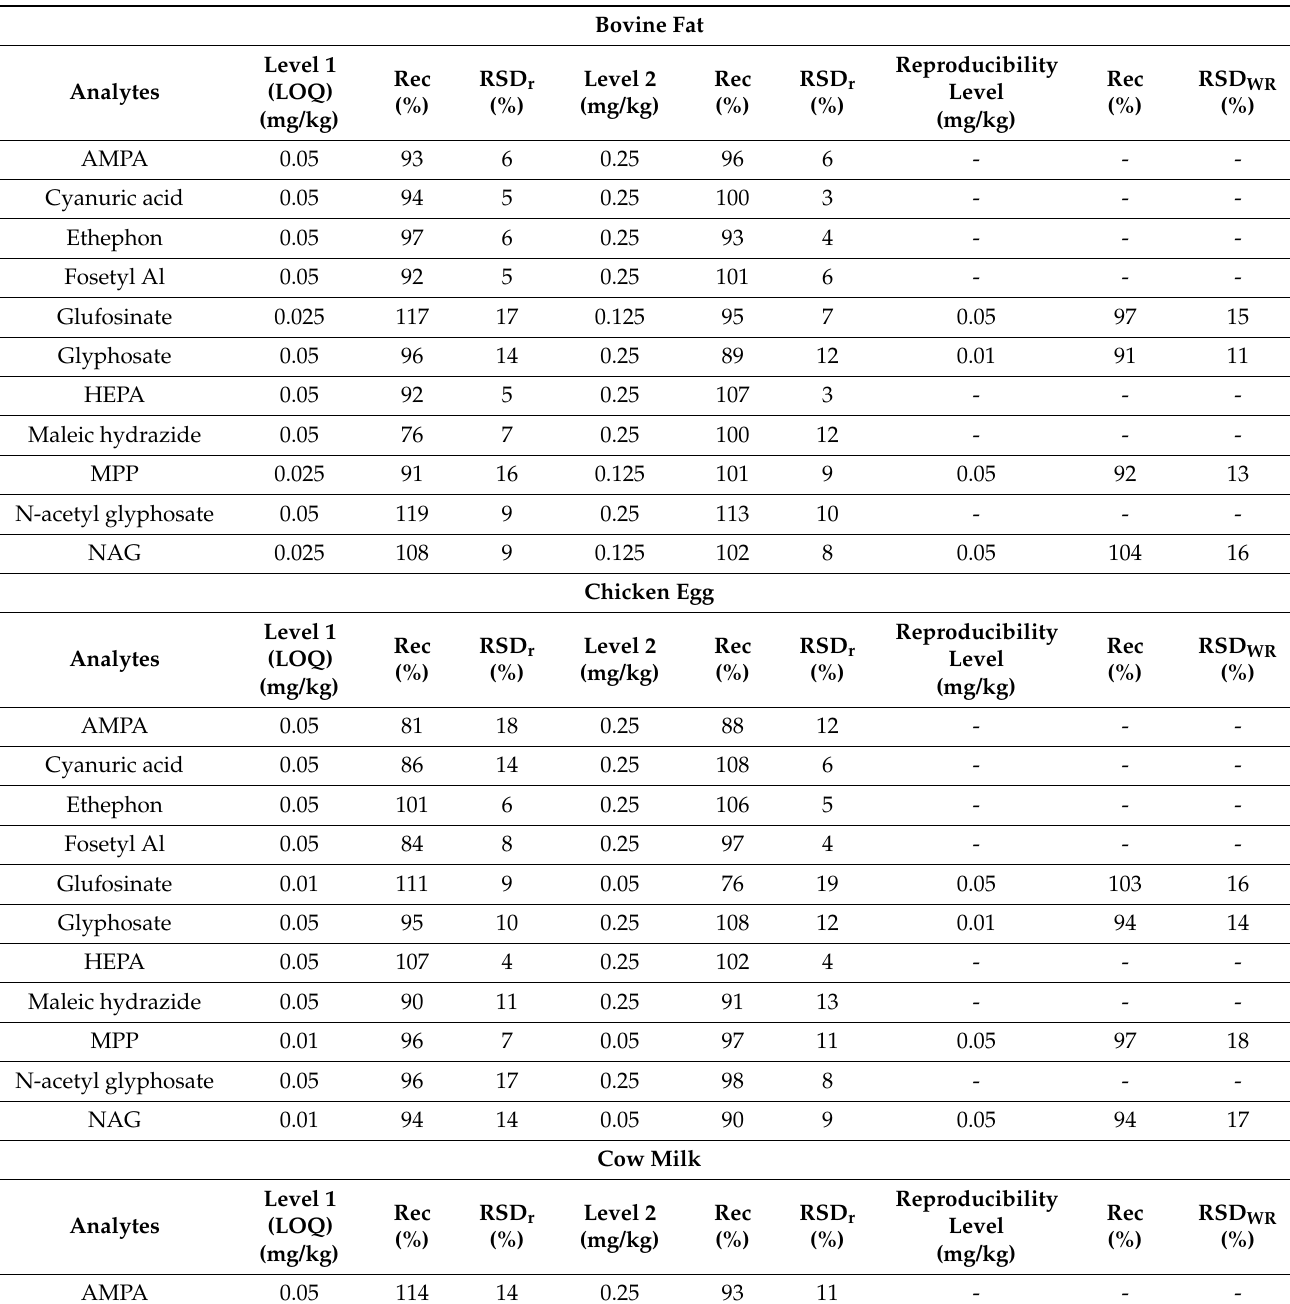
Table 3. In-house analytical performances of the LC–MS/MS method for polar pesticides in bovine fat, chicken eggs, and cow milk including spiking levels of validation (level 1, level 2), and related recovery % and repeatability (RSDr), spiking level of within-laboratory reproducibility study and related recovery ( n = 6) and within-laboratory reproducibility (RSD WLR